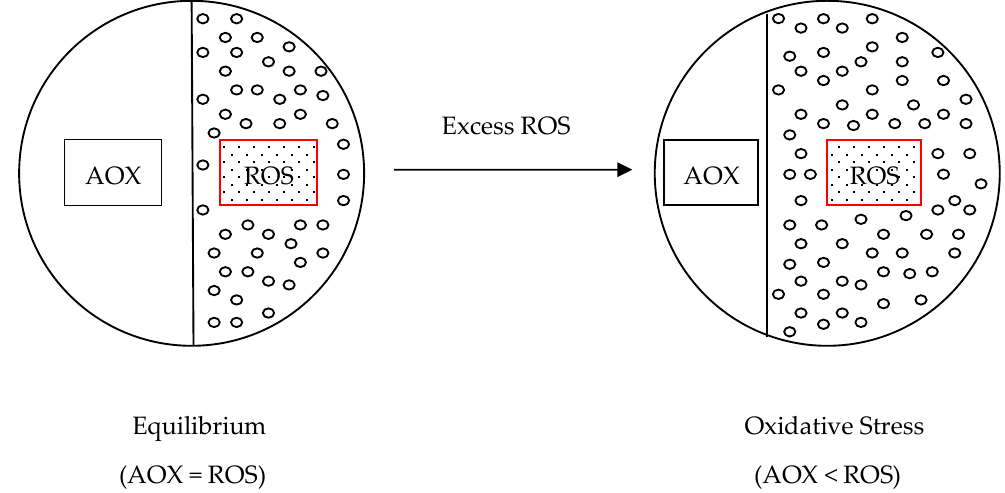
Figure 10. Relationship between oxidants (ROS) and antioxidants (AOX) leading to oxidative stress.